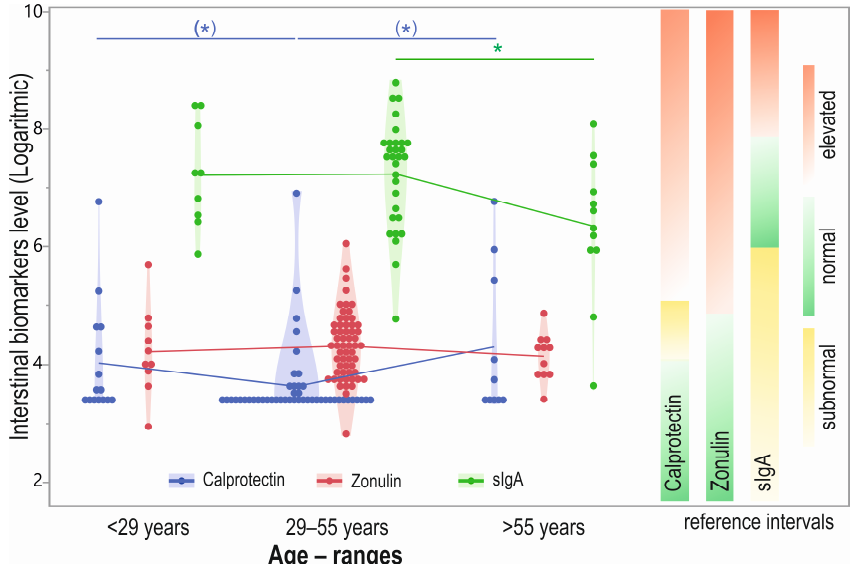
Figure 4. Stool calprotectin, zonulin, and sIgA level (log transformed) in participants distinguished by age intervals with biomarkers reference range. Designation: green—normal level; yellow—subnormal or gray-zone; red—elevated level; * p < 0.05; (*) p = 0.1–0.05. In most patients, the pathogenic microbiota level was in the normal range. Conversely, considering the immunostimulating microbiota species, the concentration was only in the normal range for E. coli NLF, in half of the patients for E. coli and both Enterococcus spp. and Bacteroides spp. were below the normal range. In the case of protective species, only half of the patients were in the normal range for Faecalibacterium prausnitzii, and lower than normal values were found in the cases of other studied species (Table 2, Figure 5).